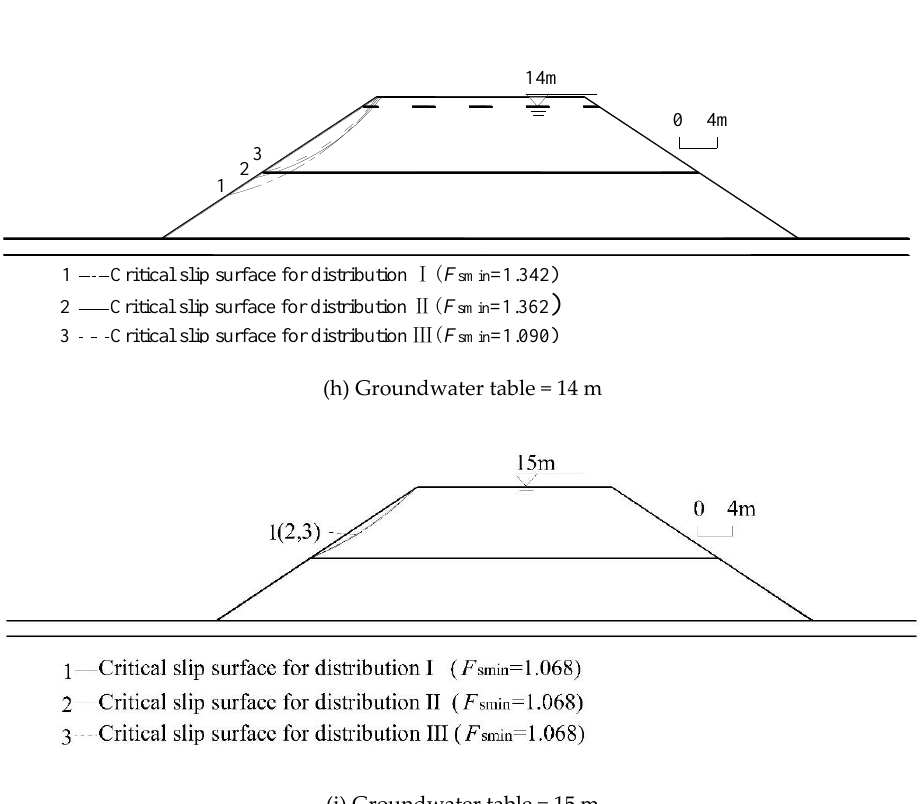
Figure 10. Critical slip surfaces associated with each distribution pattern of matric suction under rainfall infiltration.